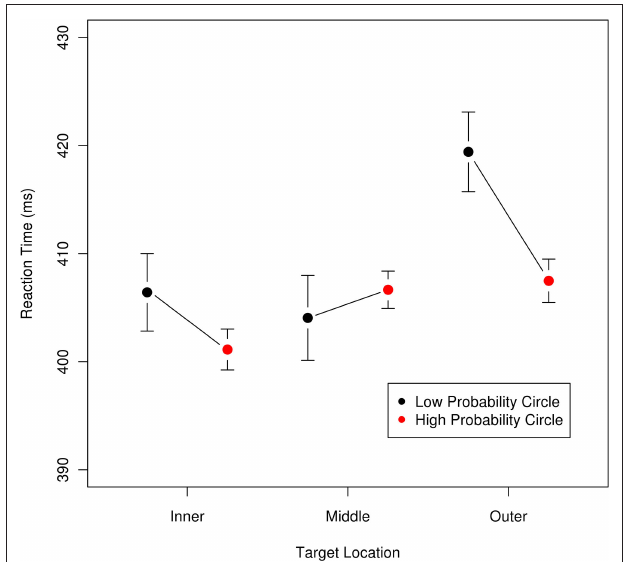
Figure 6 | Mean reaction time as a function of target location and probability; error bars are 95% confidence intervals for each location × probability condition. Targets were either on the inner, middle, or outer circle. For each circle, the right (red) point is for the trials where that circle was the high-probability location, and the left (black) point is for trials where the circle was a low-probability location. This graph is intended to visualize the magnitude and directions of the effects and thus excludes the data from two participants who had mean RTs two standard deviations away from the sample mean. Statistical analyses reported in the text include the data from all participants.